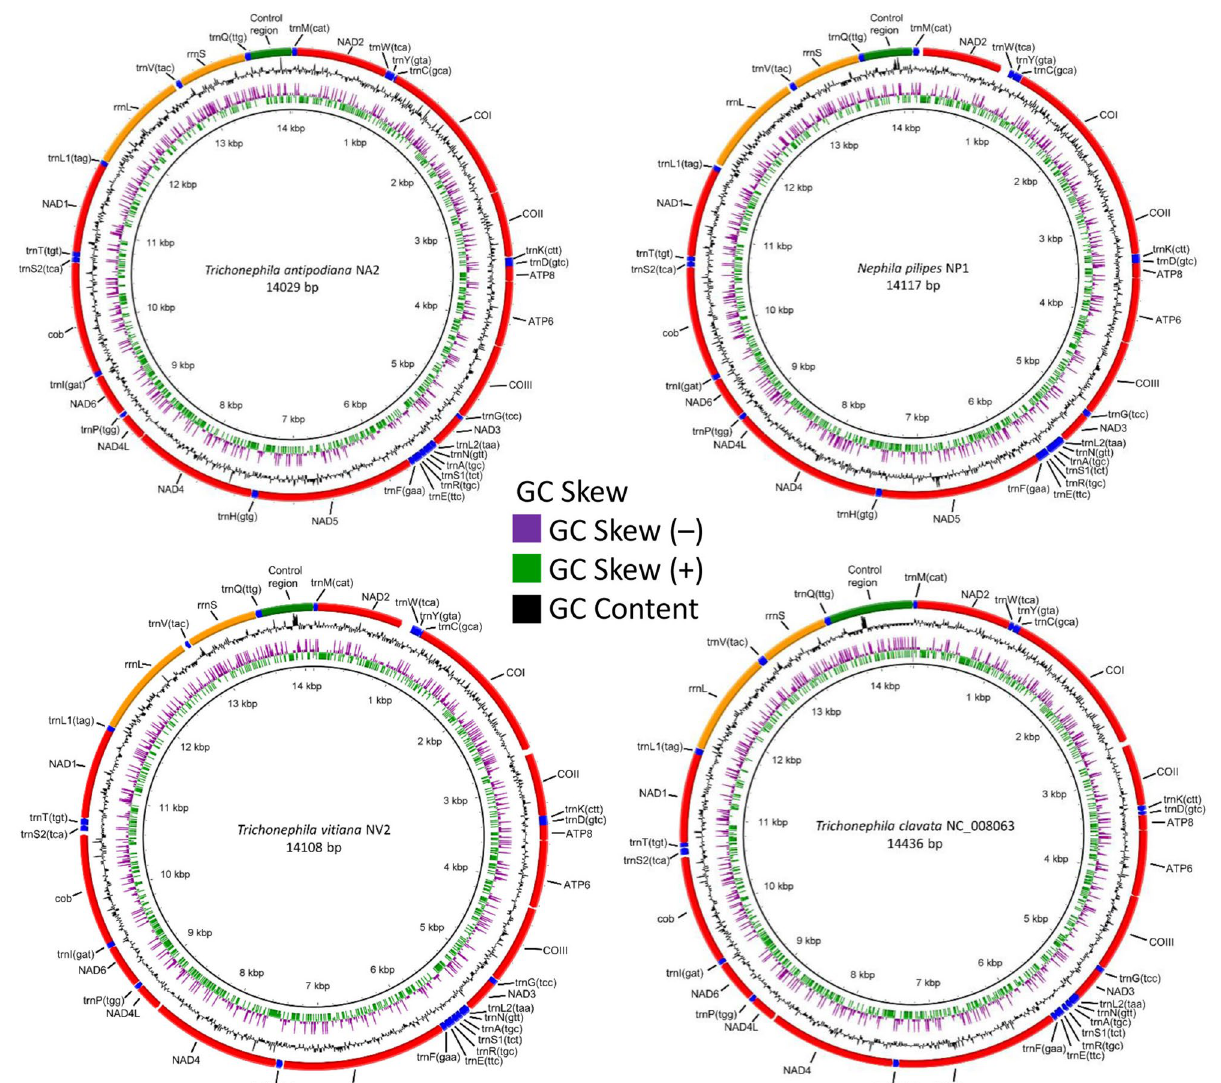
Figure 1. Complete mitogenomes of Nephila pilipes , Trichonephila antipodiana , T. vitiana (previously N. vitiana ) and T. clavata with BRIG visualization showing the protein-coding genes, rRNAs and tRNAs. GC skew is shown on the outer surface of the ring whereas GC content is shown on the inner surface. The anticodon of each tRNAs is shown in parentheses. Figure generated by BRIG Development version (0.95-dev.0004) (http:// brig. sourc eforge.